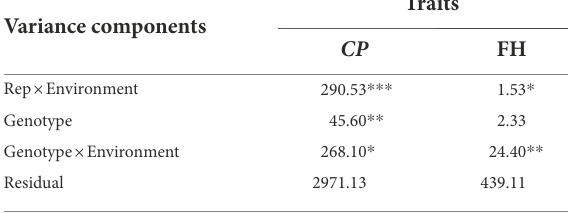
TABLE 5 Variance components and likelihood ratio tests for number of emerged adult weevils (CP) and number of feeding holes (FH) tested for three rounds of the no-choice laboratory